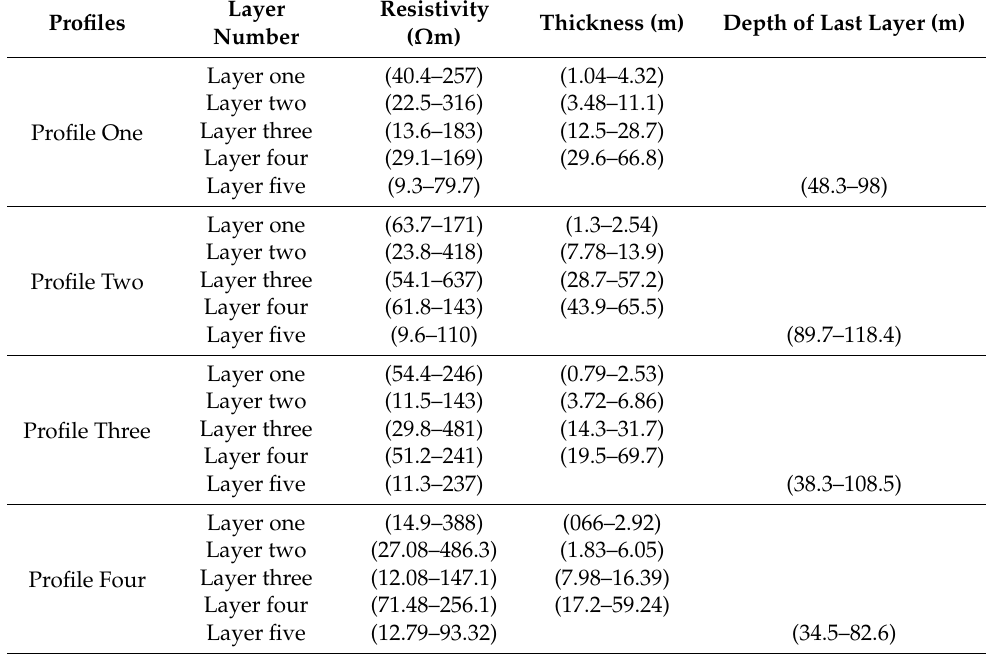
Table 2. The range of the parameters values (resistivity and thickness) resulted from 1D-LCI inversion models along the main